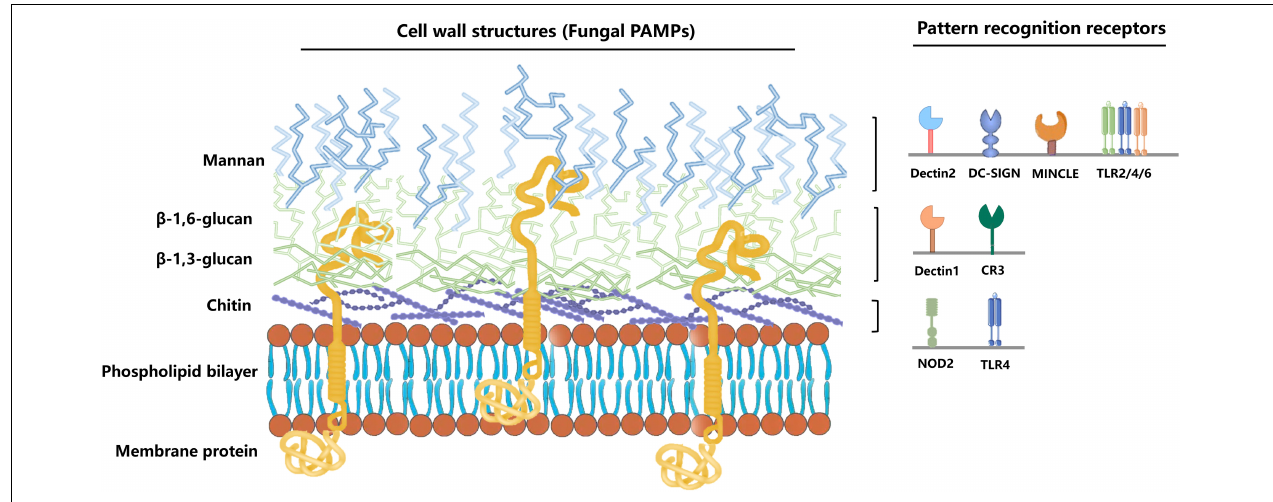
FIGURE 1 | Immune cells recognize different C. albicans PAMPs. C. albicans pathogen-associated molecular patterns (PAMPs) bind to different pathogen-recognition receptors (PRRs) of the host cell to induce immunity via the fungal cell. The outer cell wall layer is mainly composed of C-linked glycoproteins, such as mannan (80–90%). The inner cell wall contains highly immunogenic chitin, β -1,3-glucan, and β -1,6-glucan. Mannan can be recognized by the Dectin-2, DC-SIGN, MINCLE, and TLR2/4/6. Besides, β -glucan and chitin can be recognized by Dectin-1, CR3, and NOD2, TLR4, respectively.